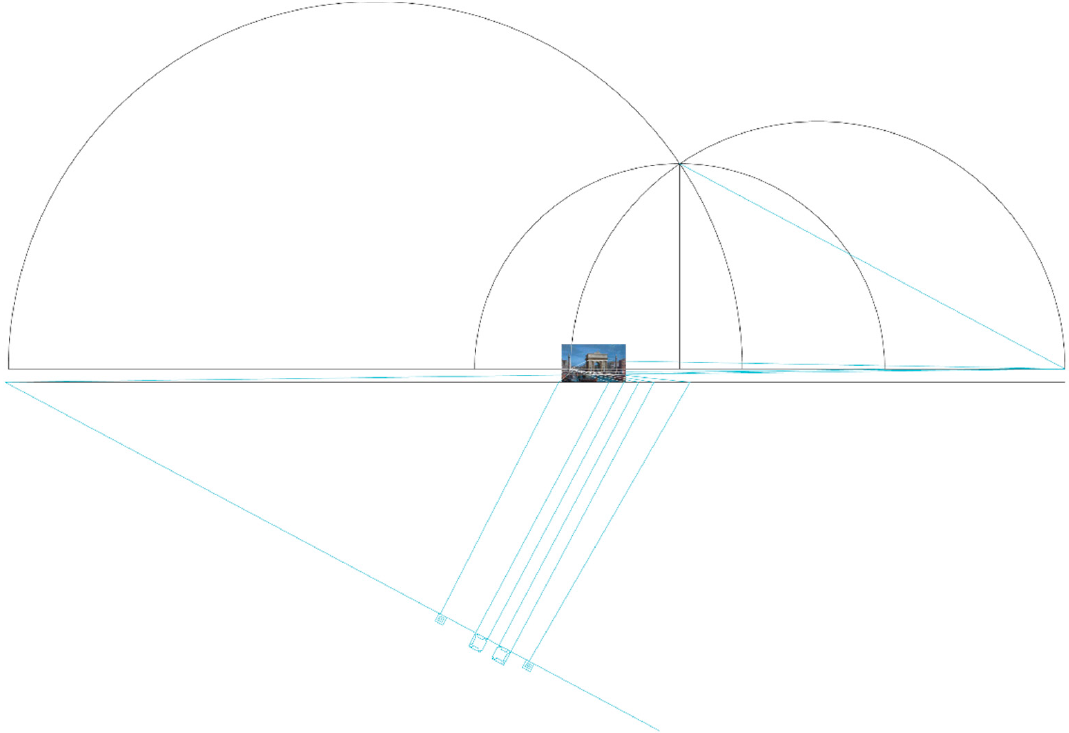
Figure 13. The determination of the position of the Triumphal Apparatus with respect to the city, based on the inverse method of perspective.